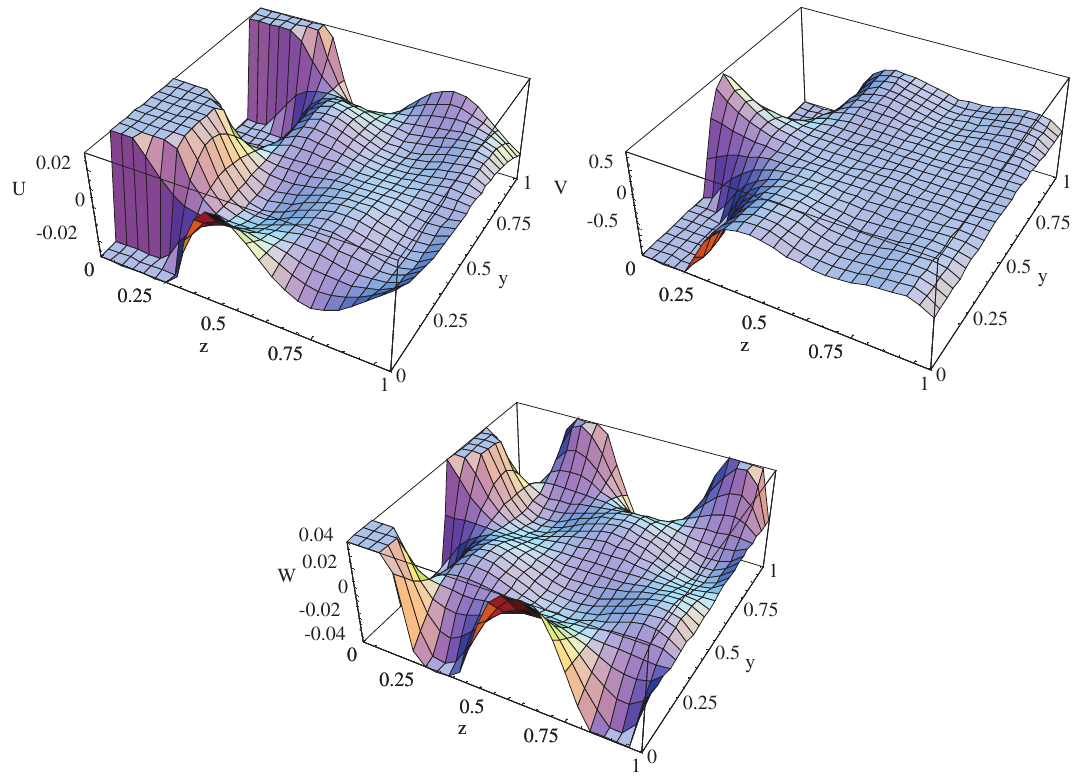
Figure 5: Displacement shapes of the first mode for the linearly FGPP square bar at kd =